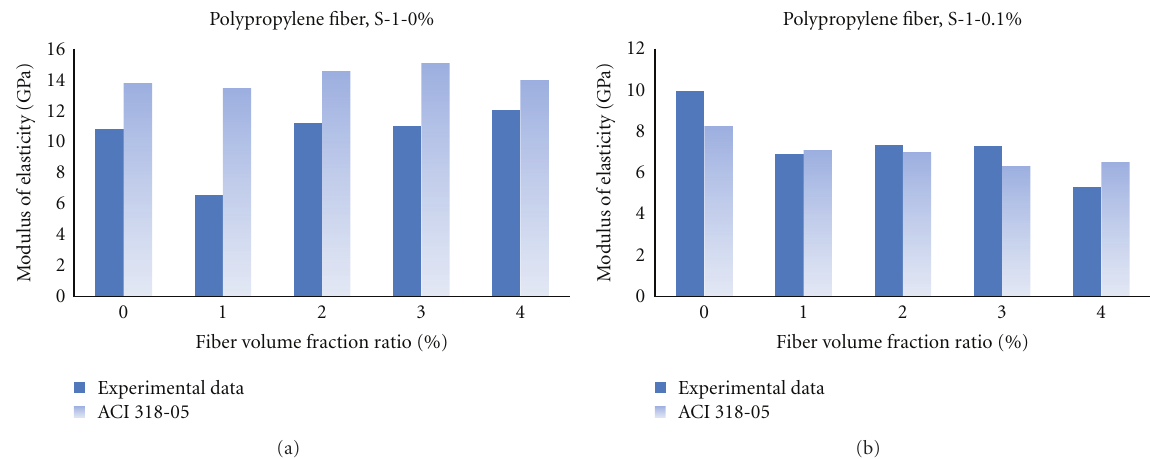
Figure 3: Comparison of modulus of elasticity of ACI code with experimental data (polypropylene fiber).